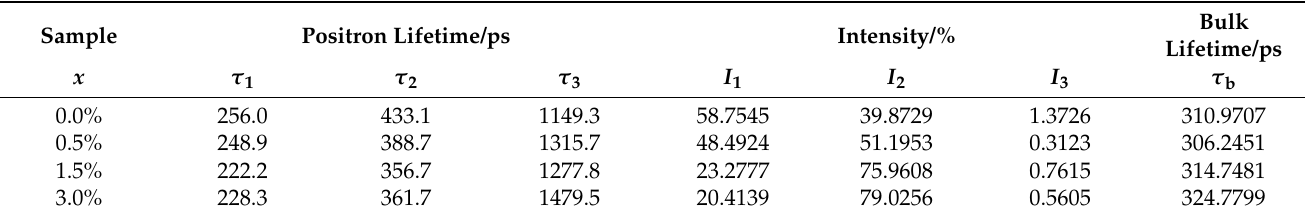
Table 2. The positron lifetime parameters τ 1 , τ 2 , τ 3 , I 1 , I 2 , I 3 and τ b of Zn-doped VO 2 (B) with different doping concentration x